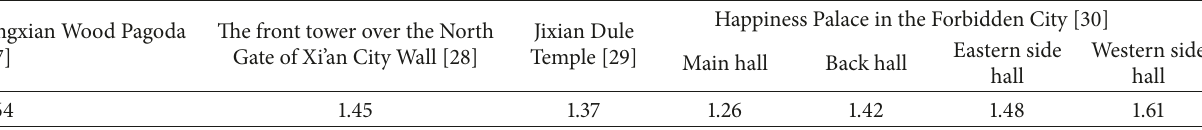
Table 1: Modal frequency of typical Chinese heritage timber buildings